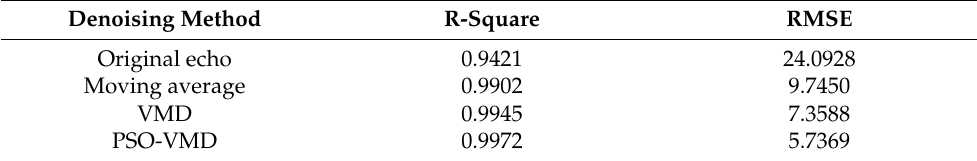
Table 1. Comparison of R-square and RMSE with the three denoising methods.